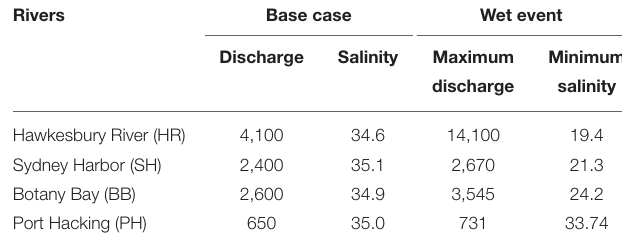
Table 1 . The base case scenario represents the “base flow” and is the annual mean discharge across the estuary entrance as derived from respective calibrated models from Sydney Water Corporation. These were further verified using the observed tidal prism. The wet case scenario is an idealization representation of the “1 in 100 year” extreme flood starting on 18 th March 2021 rainstorm event. This representation is superimposed on top of the base case to give the wet event.